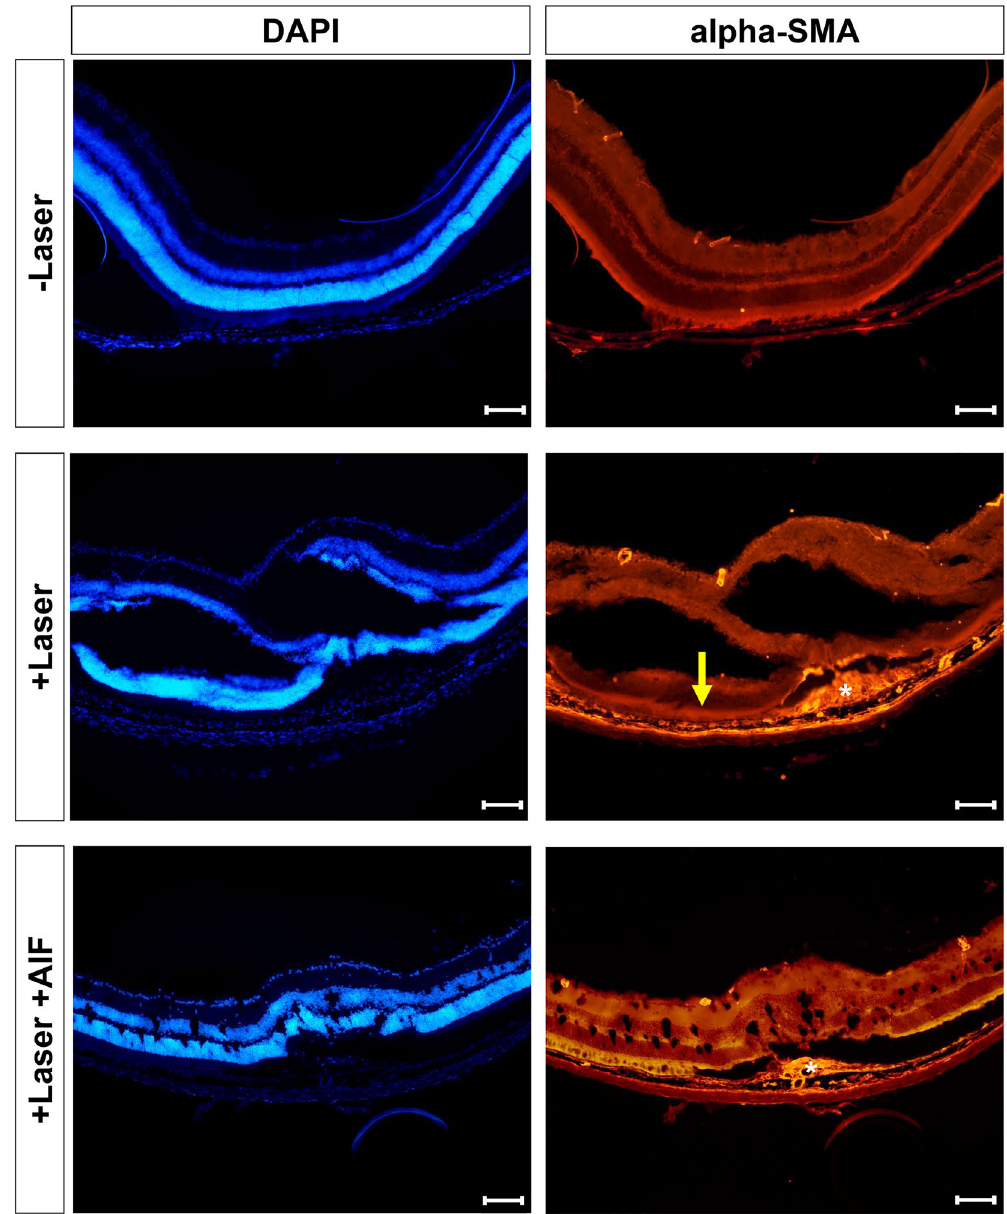
without AIF treatment stained for DAPI (blue) and alpha-SMA (red). White asterisks indicate subretinal fibrosis and increased alpha-SMA expression level. Yellow arrow depicts retinal pigment epithelium (RPE) layer. The scale bar in each image is 100